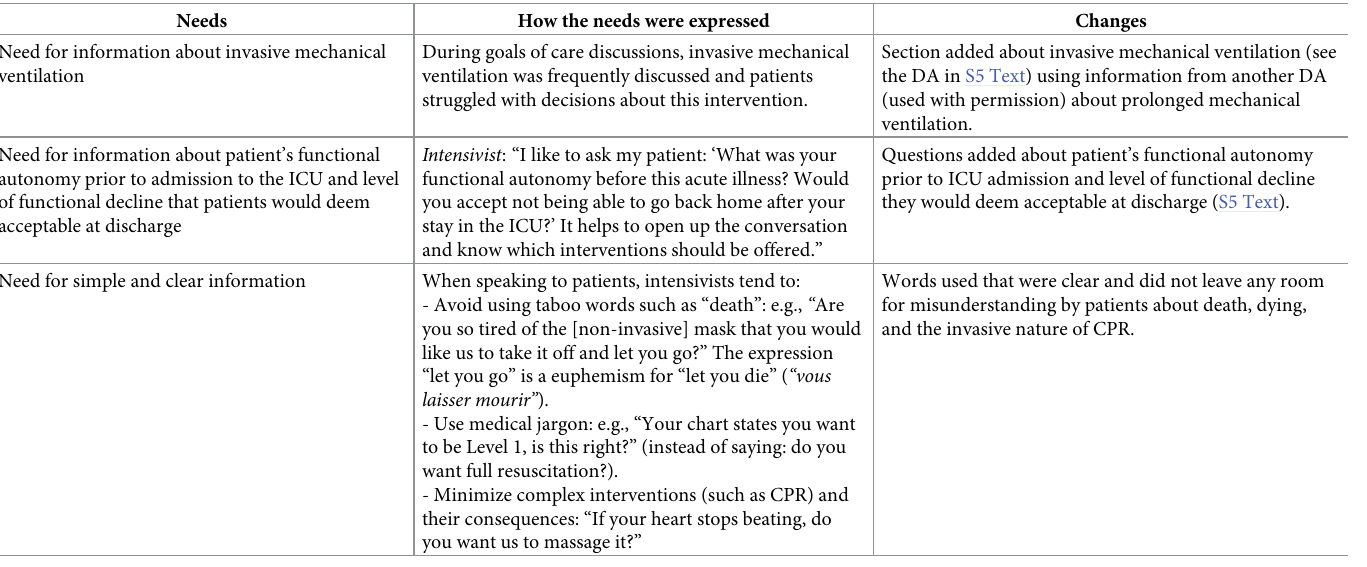
Table 1. Needs assessment results and changes made to the original